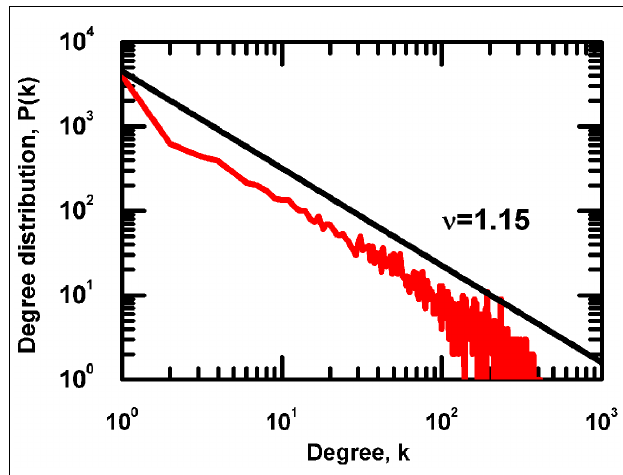
FIGURE 3 |The degree distribution for correlation network created by examining the dynamics of nodes placed on two-dimensional, regular lattice. Examined network had N = 6740 nodes and the parameters of DMM were g = 0.01 and K = 1.70.